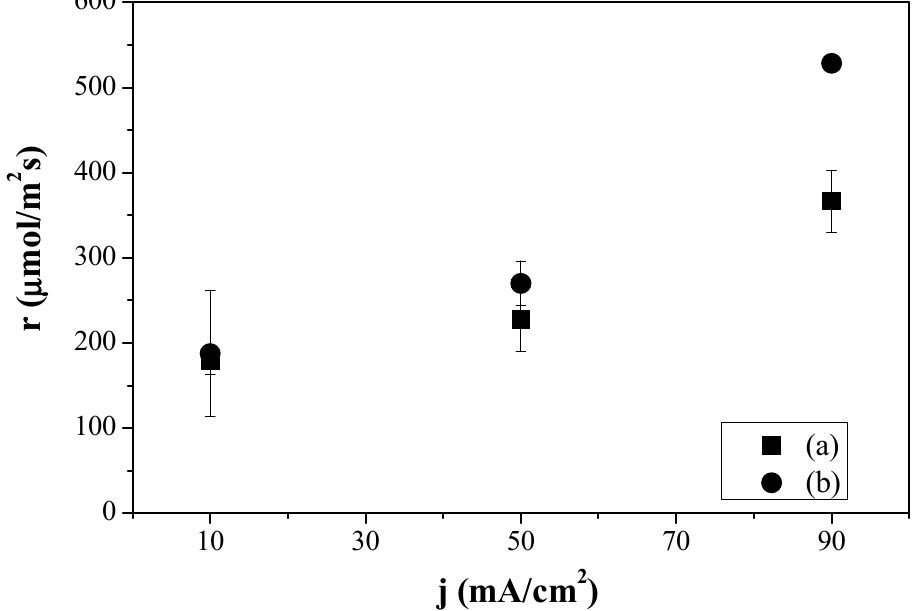
Figure 6. Production molar rates of ethylene obtained for the CS-based MEAs prepared in the laboratory, combining the Cu:CS GDE and the CS:PVA (a) and the CuY@CuUZAR-S3/CS:PVA MMM composite membrane (b) as a function of the applied current density.